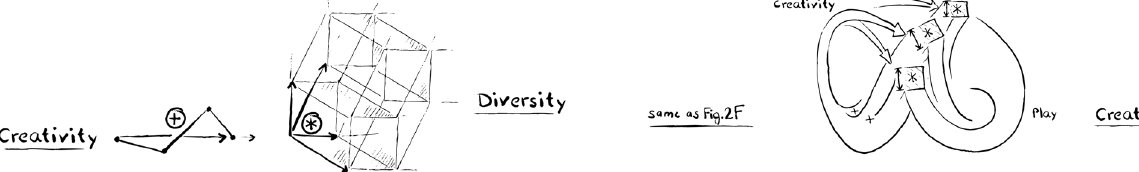
Fig. 10 The model of creative play of Fig. 2F visualized in lines-planes style. Like all other models, the model of creative play can also be visualized in a graphical language inspired from geometry. Play is multidimensional; it creates planes. Each act of interplay is rendered here as a rectangle. The rectangle ’ s height represents the value of x i . Its length represents the value of f i ( x ). Creativity is linear in that it in fl uences only the height of the rectangles. If you look carefully at this model, you can recognize in it the general models of creativity and play of Fig. 2B and E.